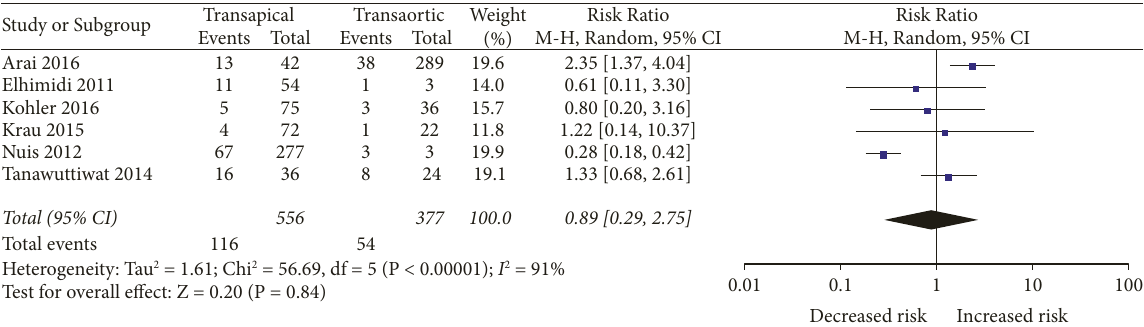
Figure 3: Forest plot comparing the risk of developing AKI between TF and TAo TAVR